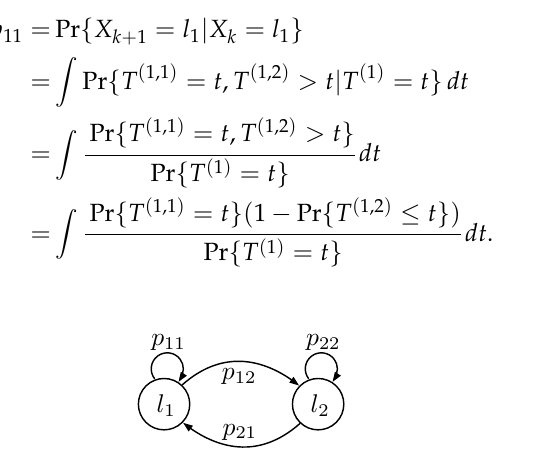
Figure 4. Two-lane state Markov chain